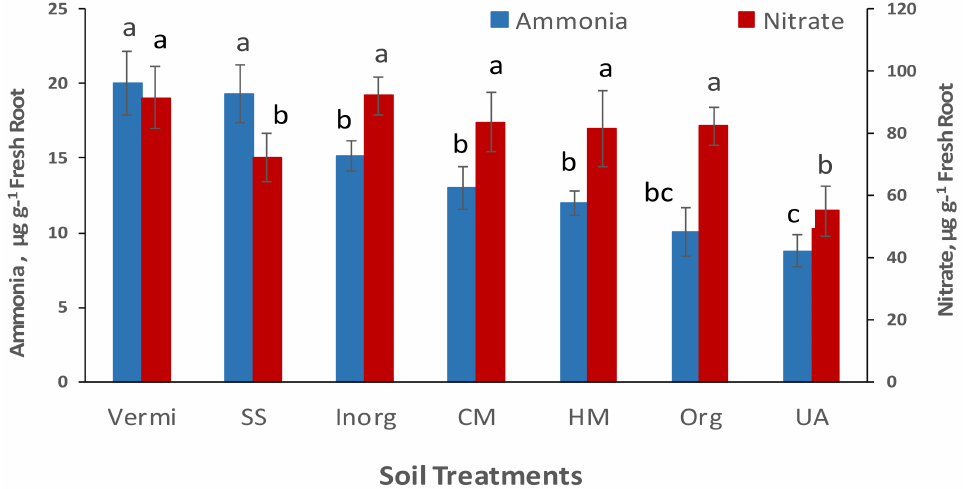
Figure 2. Concentrations of ammonia and nitrates ± std. error in turnips roots of plants grown under seven soil treatments, regardless of turnips variety. Vermi vermicompost, SS sewage sludge, Inorg inorganic fertilizer, CM chicken manure, HM horse manure, Org elemental organic fertilizer, and unamended (UA) native soil. Statistical analysis was carried-out using analysis of variance (ANOVA). Standard errors having different letter(s) indicate significant differences ( p ≤ 0.05) using Duncan’s multiple range